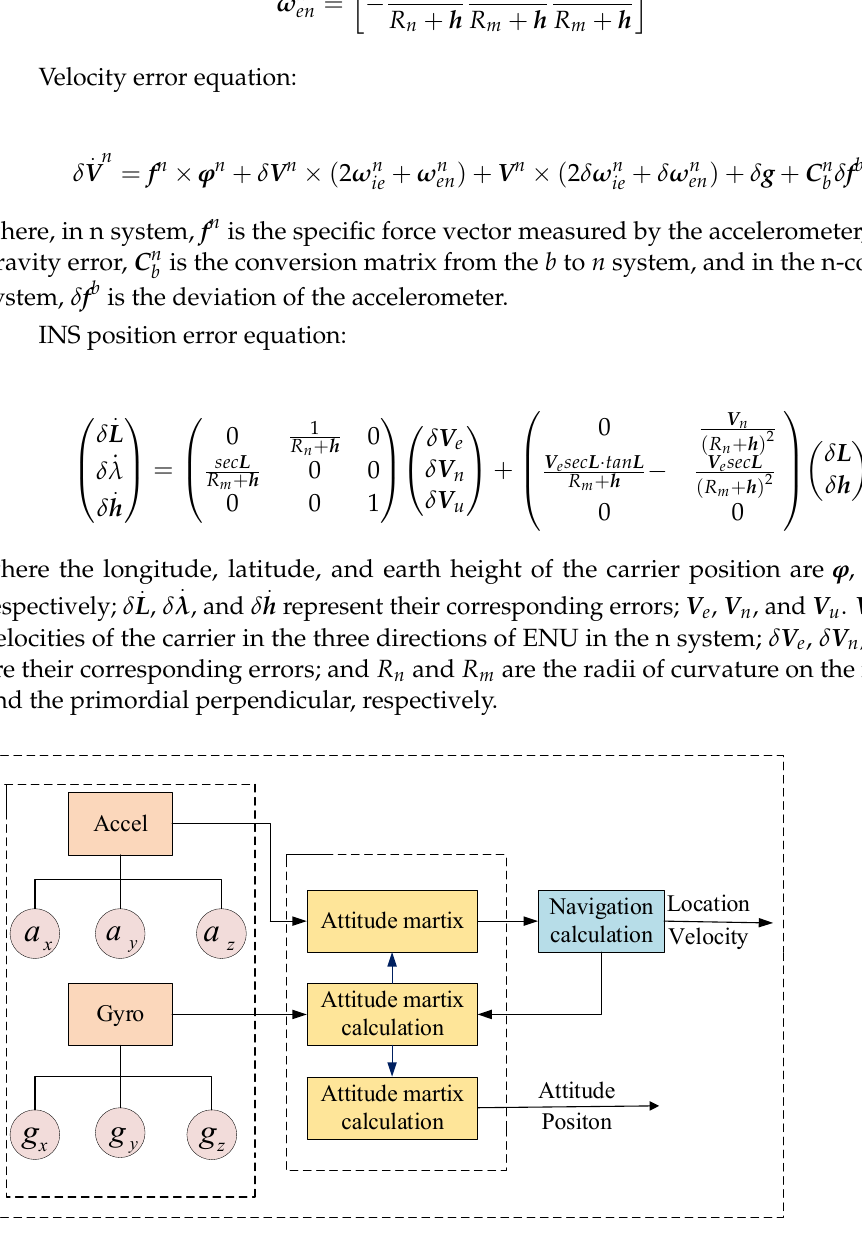
Figure 1. Inertial navigation system (INS) solution diagram.